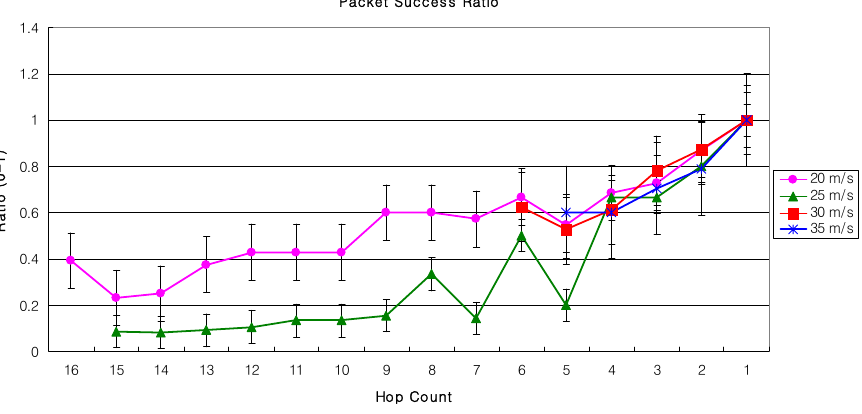
Figure 17. Packet success rate vs. number of hops with variable MN’s speed (LoWMob).